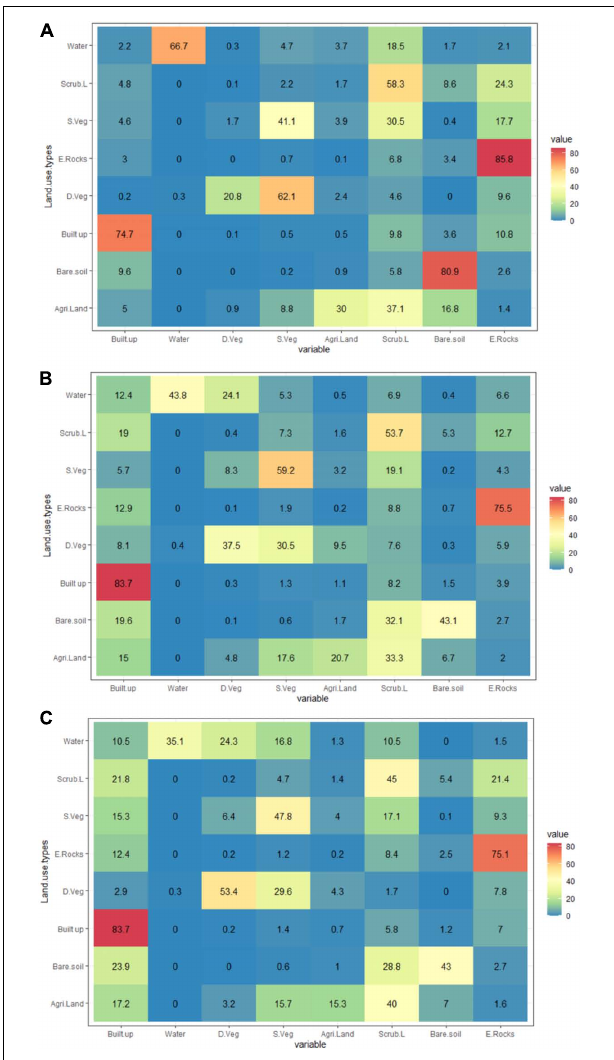
FIGURE 2 | Transition probabilities of different LULC classes between the period of (A) 1990–2000, (B) 2000–2018, and (C) 1990–2018.